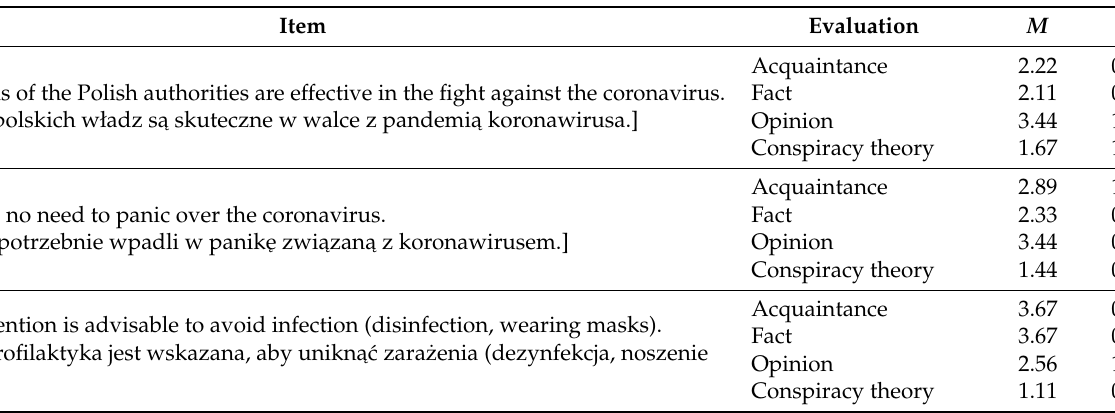
Table A1. The assessments of coronavirus facts, opinions, and conspiracy theories items from nine judges. The acquaintance of information contained in each item was also